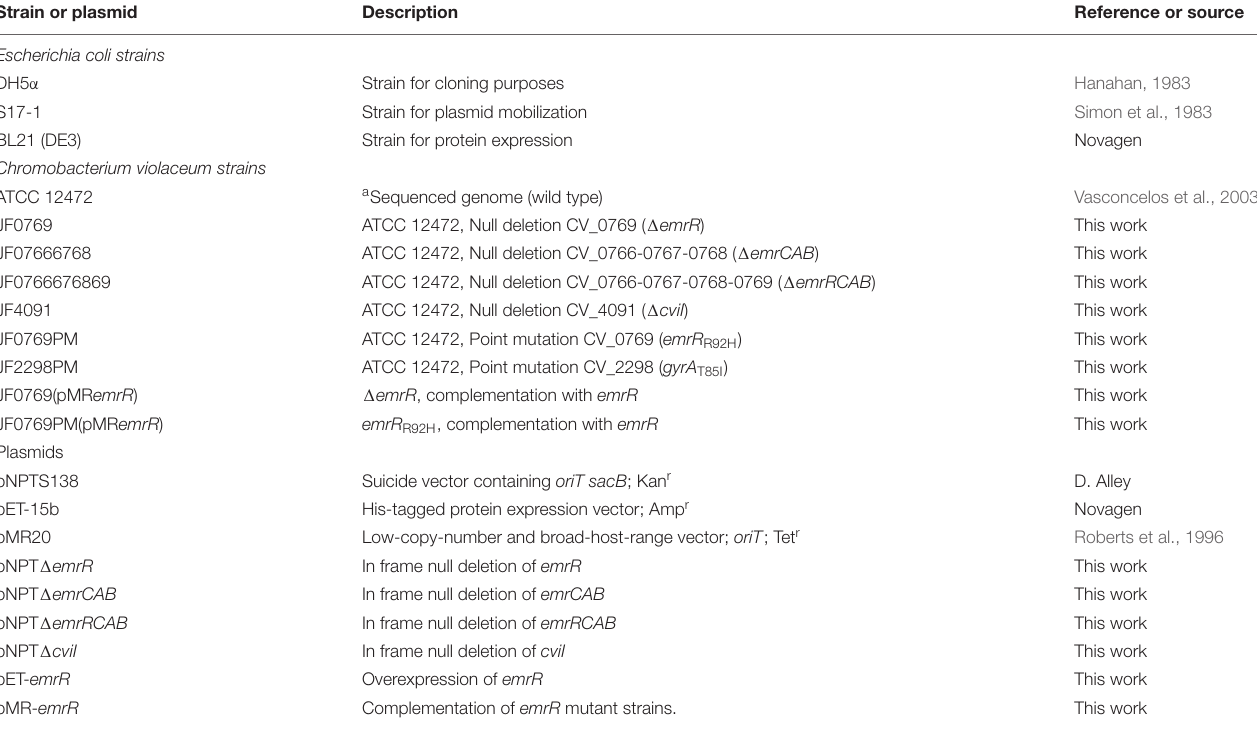
TABLE 1 | Bacterial strains and plasmids used in this